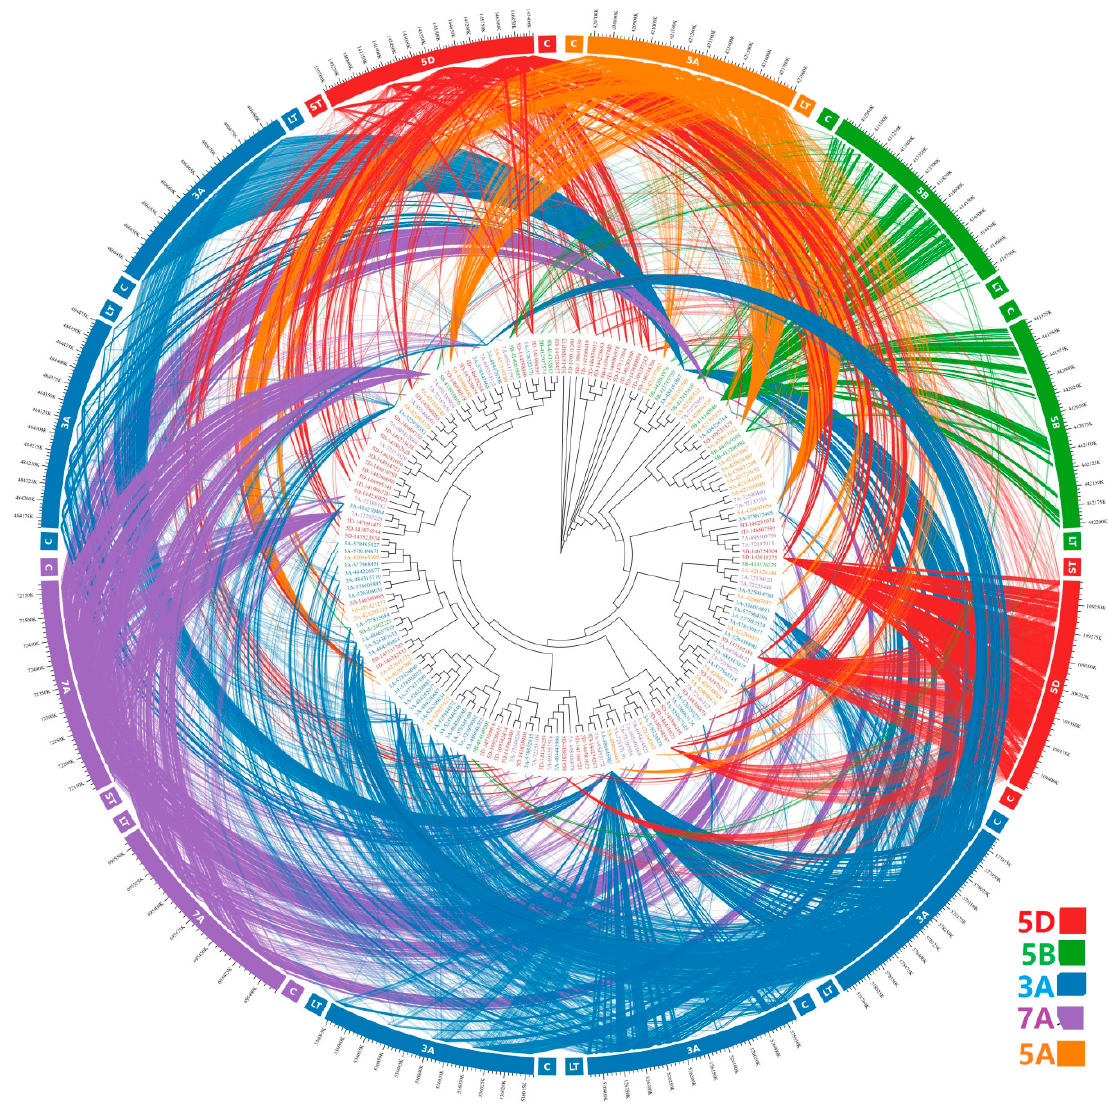
Figure 3. Phylogenetic tree of Ta-3A1 repeats and their physical location on five wheat chromosomes.